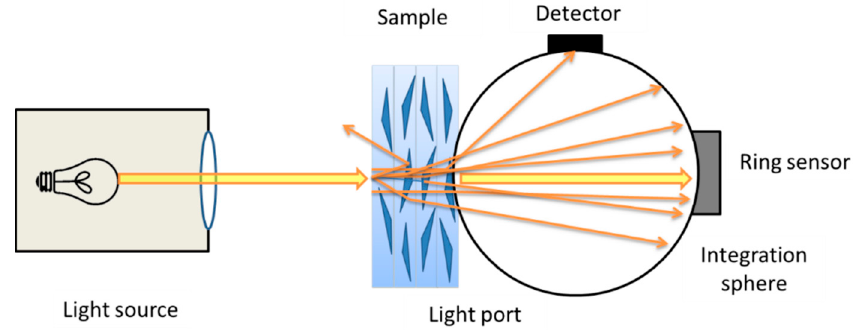
Figure 8. Measurement principle of a haze meter.